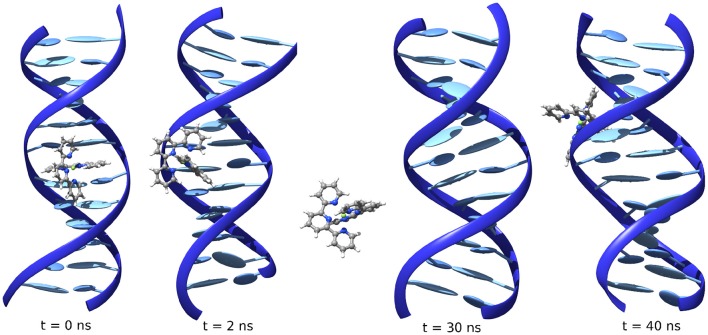
Evolution of the position of FeC-1 interacting with poly(dG)-poly(dC) starting from intercalation.